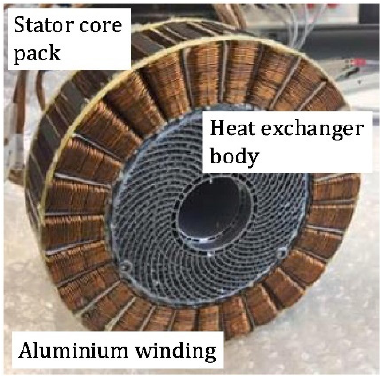
Figure 10. 3D ‐ printed axial heat exchanger of an outer rotor EM with concentrated coils, repro ‐ duced with permission from [144]. Copyright Elsevier 2020. with permission from [144]. Copyright Elsevier